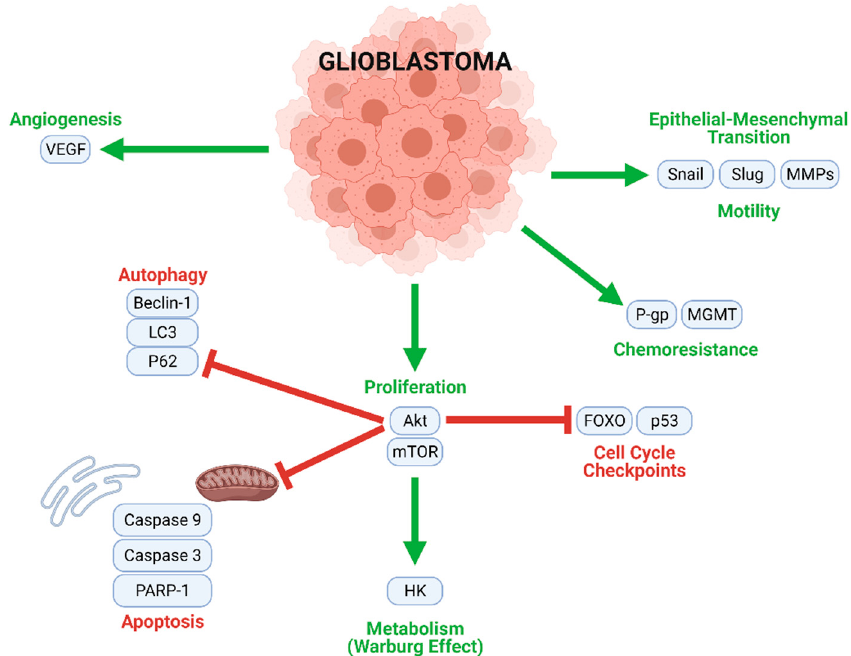
Figure 3. Multiple intracellular processes contribute to GBM tumorigenesis and progression. Mech- anisms contributing to proliferation, chemoresistance, metabolism, angiogenesis, and motility (mi- gration) are upregulated in GBM cells, while cell cycle checkpoints, autophagy, and apoptosis are inhibited.